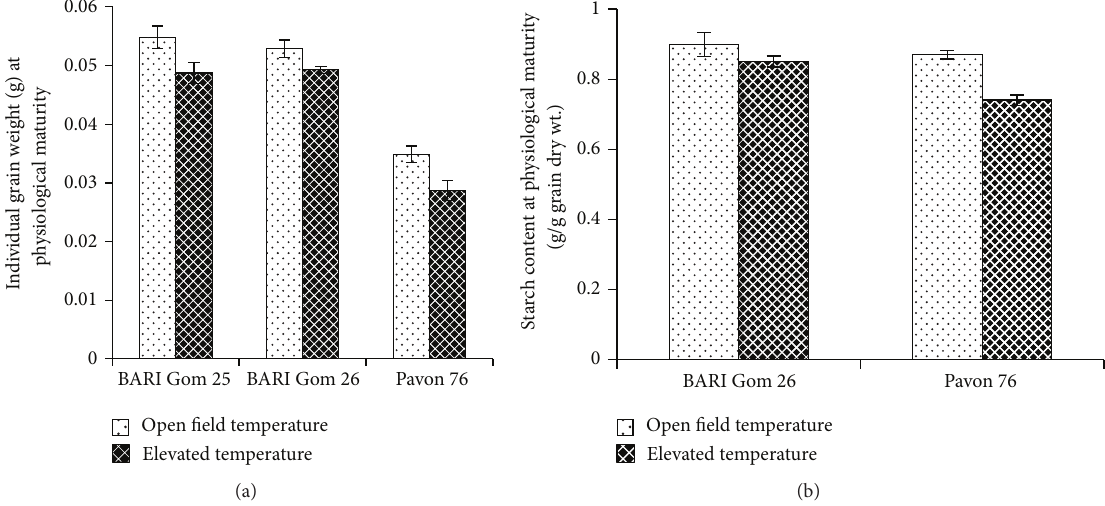
Figure 3: (a) Individual grain weight in three wheat cultivars and (b) starch content in two cultivars at physiological maturity under open field and elevated temperature conditions. Vertical lines are standard errors of mean data